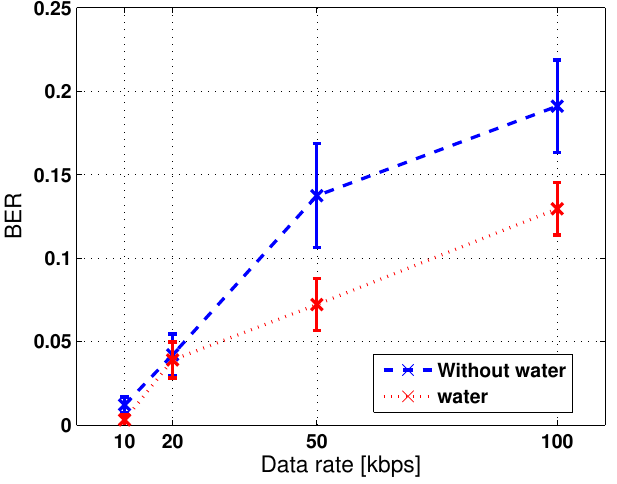
Figure 11. Obtained bit error rate versus data rates of R = 10 , 20 , 50 , 100 kbps for stainless steel pipe specimen.